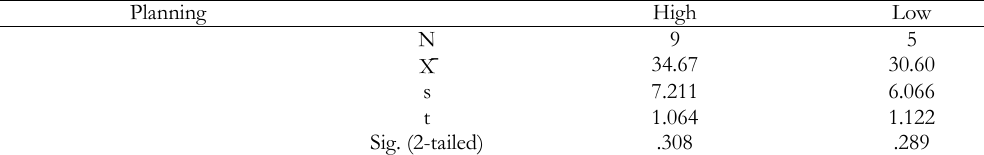
TABLE 1. Independent T-test for Planning Strategy on Metacognitive Writing Strategies Planning